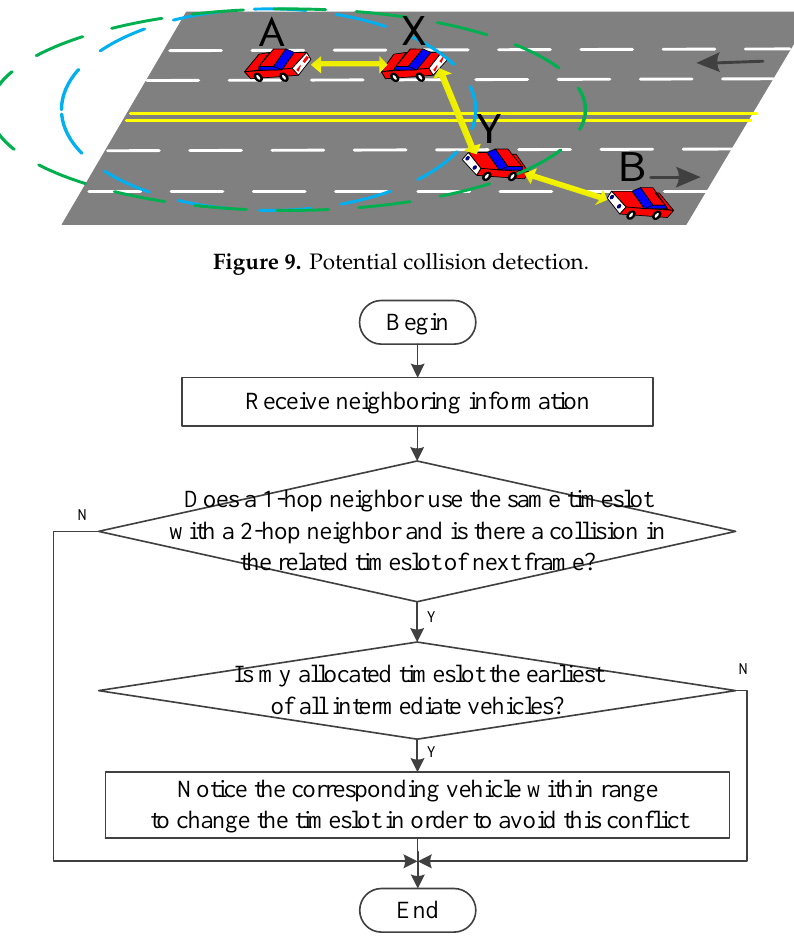
Figure 10. The process of avoiding potential collisions by intermediate vehicles.